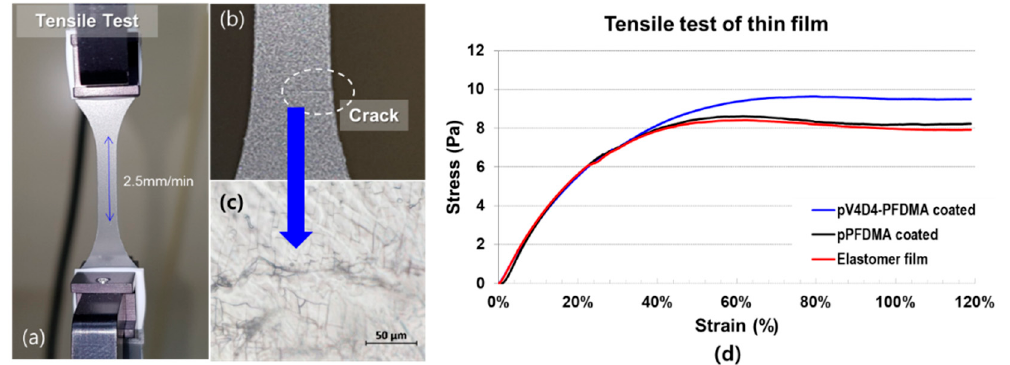
Figure 5. Tensile test of the elastomer film with superhydrophobic coating: ( a ) tensile test set-up; ( b ) surface cracks occurred during tensile loading; ( c ) microscopic image of the surface cracks; and ( d ) stress-strain curves.